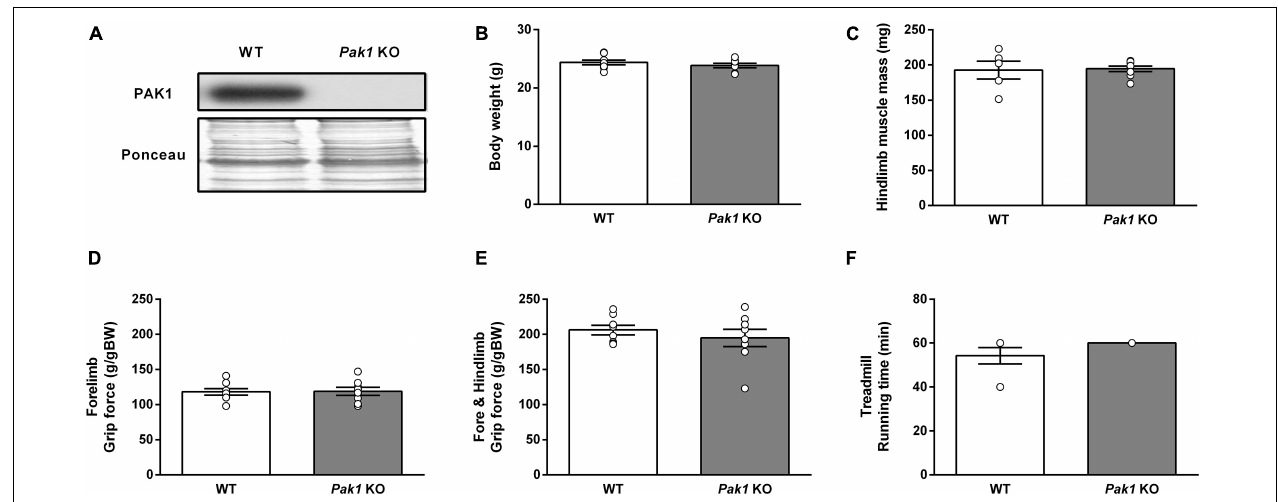
FIGURE 2 | Deletion of Pak1 does not alter muscle mass and function. (A) Representative western blot image of muscle PAK1 protein levels in GC muscles from Pak1 KO vs. WT mice. (B) Body weight, and (C) hindlimb muscle mass (including TA, GC, SOL, and EDL muscles) from Pak1 KO vs. WT mice ( n = 5–8/group). (D,E) Muscle strength from Pak1 KO vs. WT mice ( n = 7–8/group). Mice were lowered on a grid connected to a sensor to measure the muscle force of their forelimbs or of both their forelimb and hindlimb and data were then expressed in gram force relative to body weight (g/gBW). (F) Endurance tolerance from Pak1 KO vs. WT mice ( n = 7–8/group). Mice were submitted to an incremental treadmill running exercise (from 5 m/min with added 1 m/min every min until maximum 18 m/min) for a maximum running time of 60 min. Results are expressed as means ± SEM and statistical analysis was performed using unpaired t -test to compare results from Pak1 KO and WT